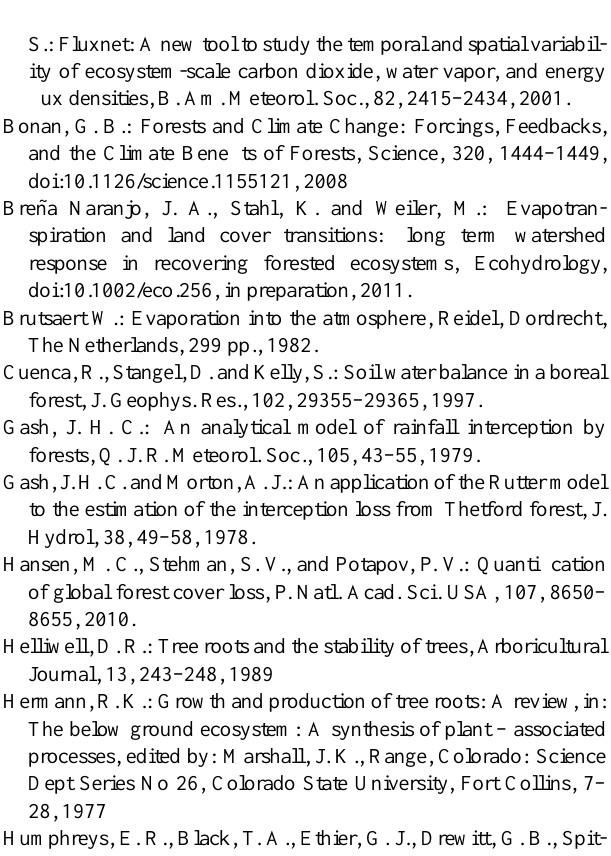
of the closure when excluding the late evening/nocturnal pe- riods (Fig. A1, right side) was moderate at the IS and MS but did not have any effect at the YS (Table